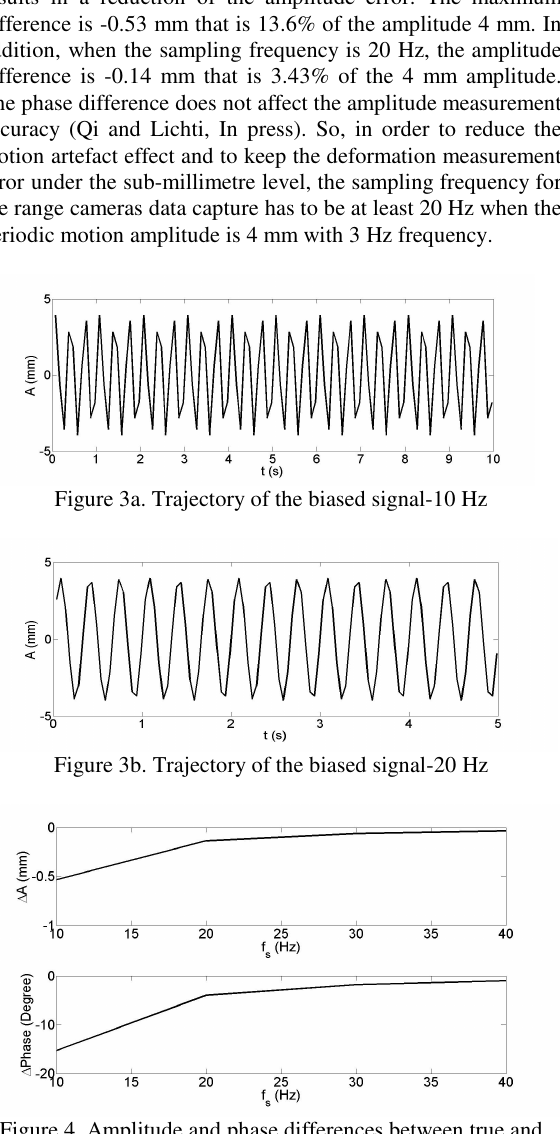
Figure 2. Precision analysis to the range camera